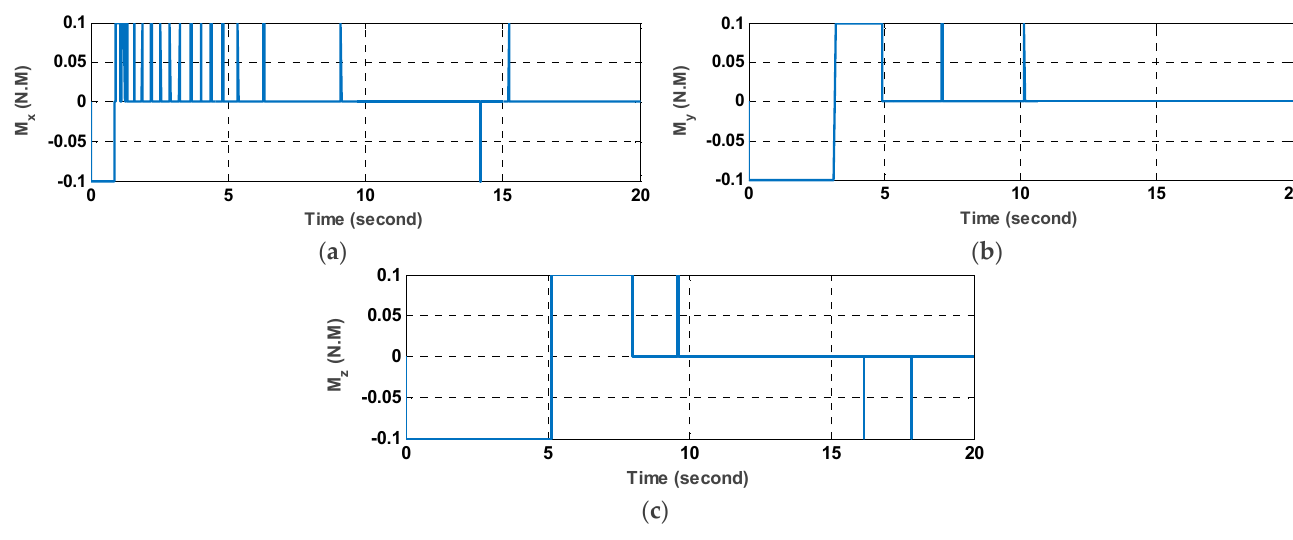
Figure 12. The control moment of the thruster in the ( a ) X, ( b ) Y, and ( c ) Z axis.